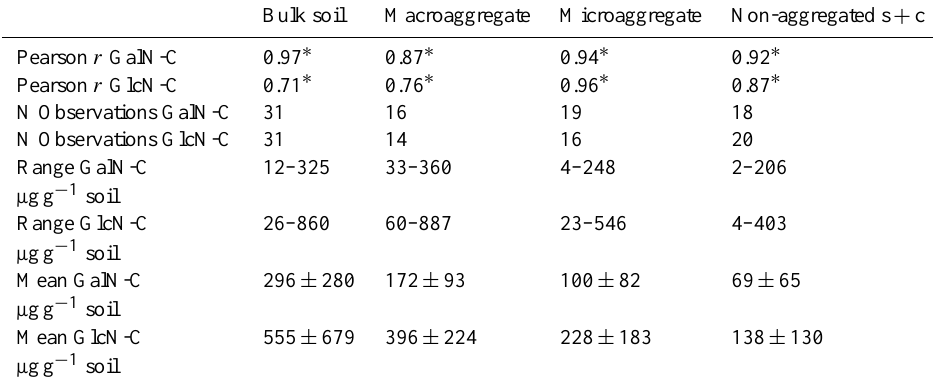
Table 4. Correlations (Pearson r ) between SOC and the extracted AS galactosamine (GalN) and glucosamine (GlcN) from different fractions ( ∗ = p <0.1).